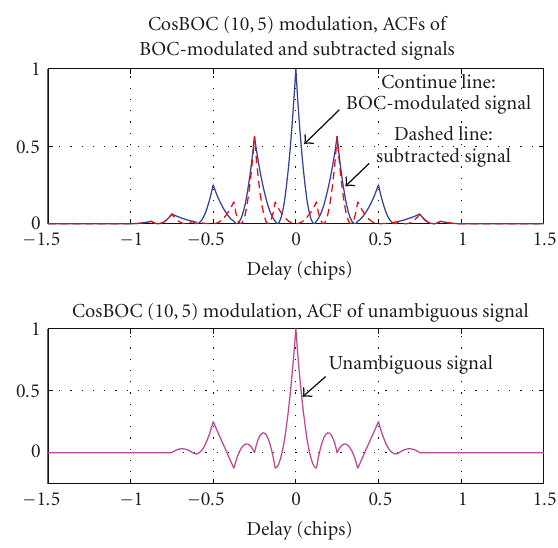
Figure 9: CosBOC(10,5)-modulated signal: examples of the am- biguous correlation function and subtracted pulse (upper plot) and obtained unambiguous correlation function (lower plot), in a single-path